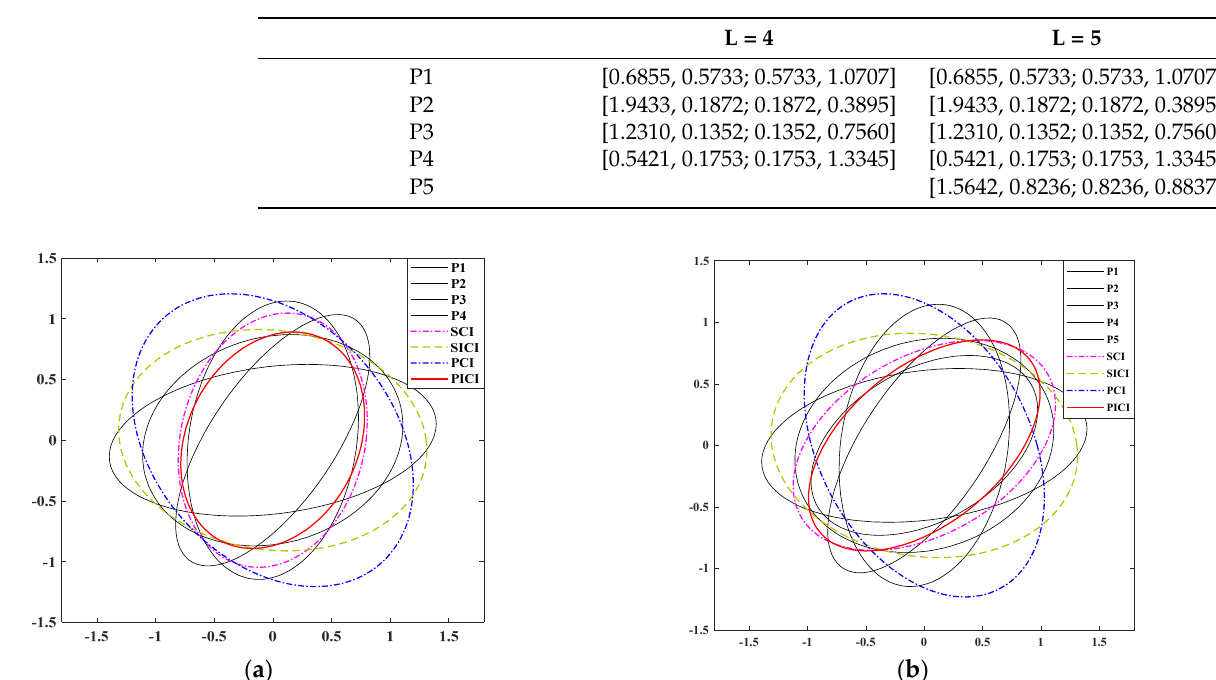
Figure 4. This shows that the covariance ellipse of the ICI algorithm is visibly higher than the fusion precision of the CI algorithm regardless of whether L = 4 or L = 5, and the fusion effect of the PICI fusion algorithm is stronger than other algorithms. Table 1. Value of covariance ellipse under L = 4 and L = 5.